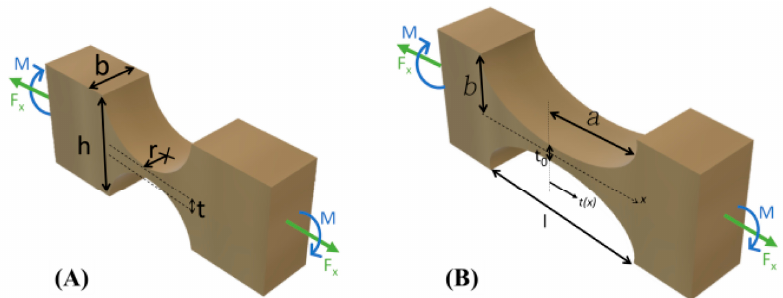
Figure 6. Generalized model of the ( A ) circular hinge and ( B ) elliptical hinge(right) [50]. Key geometrical parameters for circular hinges are denoted as b, t and r for the thickness of circular hinges, web thickness and hinge radius respectively